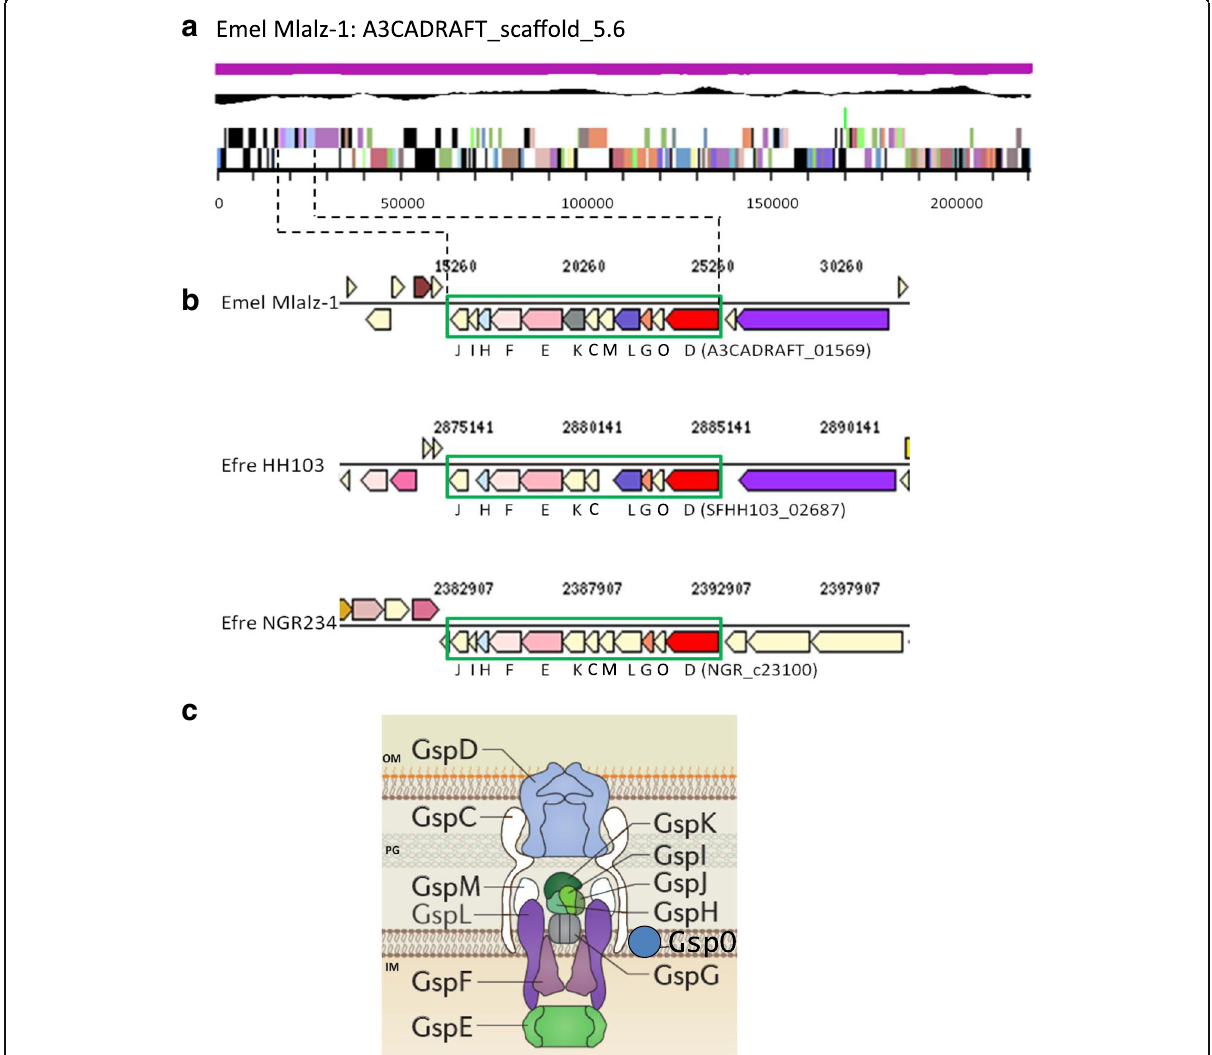
Fig. 3 a Map of Ensifer meliloti Mlalz-1: A3CADRAFT_scaffold_ 5.6. b Genetic organization of the T2SS clusters in E. meliloti Mlalz-1 ( Emel Mlalz-1), Ensifer fredii HH103 ( Efre HH103) and Ensifer fredii NGR234 ( Efre NGR234). J, gspJ ; I, gspI ; H, gspH ; F, gspF ; E, gspE ; K, gspK ; C, gspC ; M, gspM ; L, gspL ; G, gspG ; O, gspO ; D, gspD . c Schematics of the T2SS of Gram-negative bacteria [43]. The secretin, GspD (A3CADRAFT_01569); the polytopic protein, GspF (A3CADRAFT_01561); the cytoplasmic ATPase, GspE (A3CADRAFT_01562); the major pseudopilin component, GspG (A3CADRAFT_01567); the minor pseudopilins, GspH (A3CADRAFT_01560), GspI (A3CADRAFT_01559), GspJ (A3CADRAFT_01558) and GspK (A3CADRAFT_01563); the bitopic proteins, GspL (A3CADRAFT_01566), GspC (A3CADRAFT_01564) and GspM (A3CADRAFT_01565); the peptidase, GspO (A3CADRAFT_01568)(GspS is absent from Mlalz-1); OM, outer membrane; PG, peptidoglycan; IM, inner